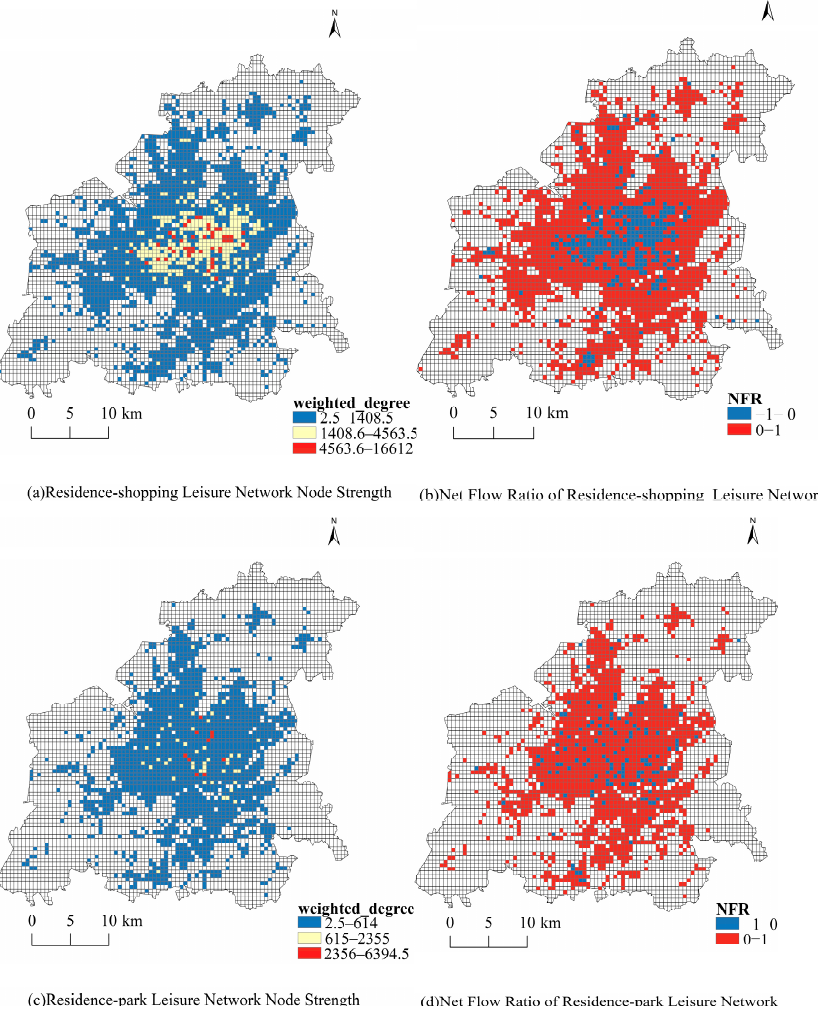
Figure 3. Spatial distribution of node degrees of residence–leisure networks for different travel purposes.